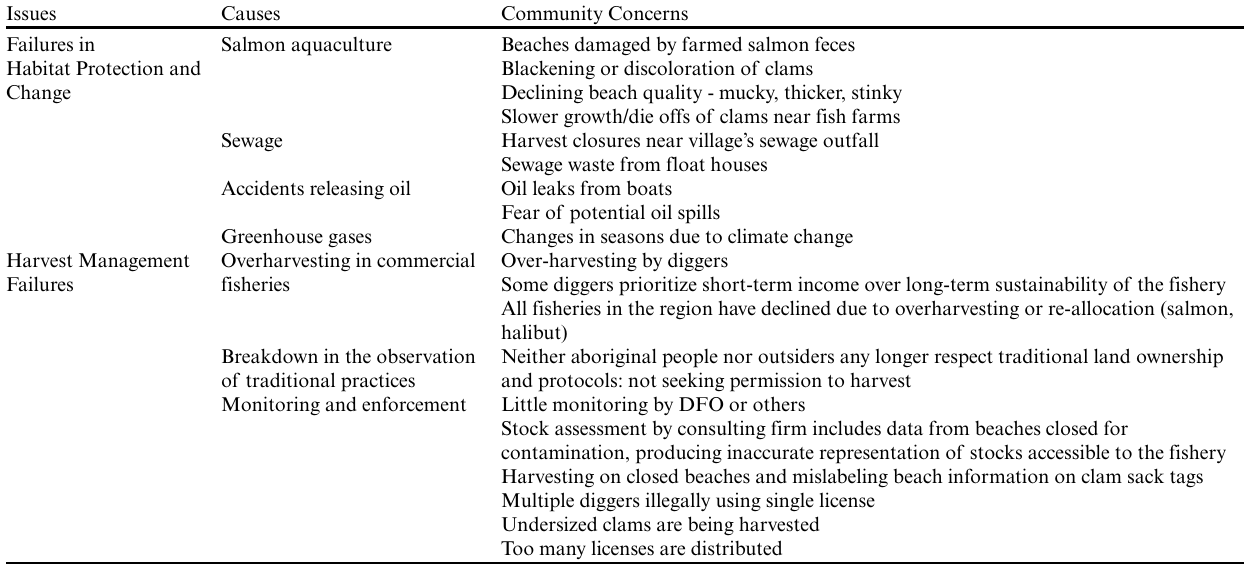
Table 5 . Broughton clam group members’ identification of problems in clam